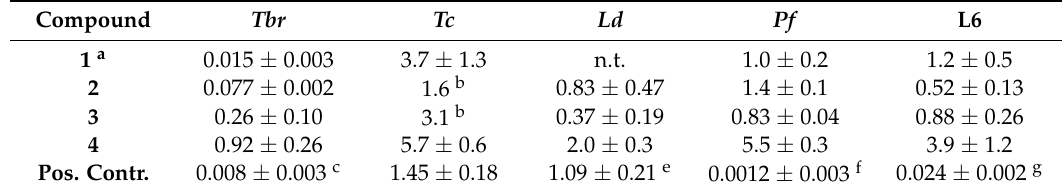
Table 2. Antiprotozoal and cytotoxic activity data of the isolated STLs (IC 50 values in µ M; means of two independent determinations ± deviation from the